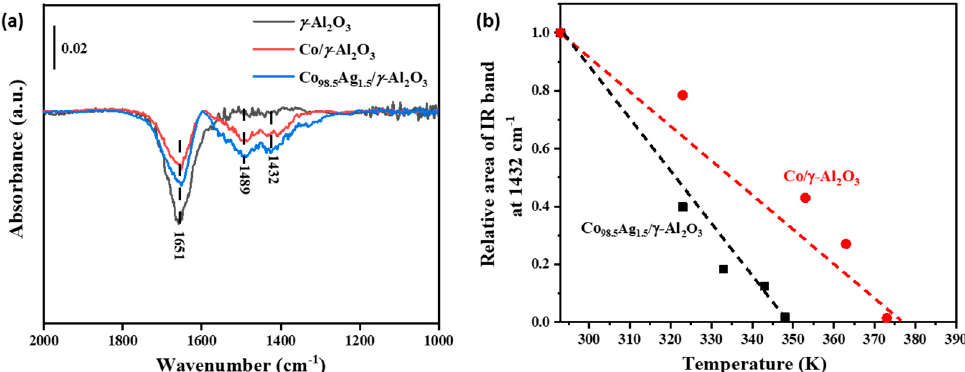
Figure 8. ( a ) Diffuse reflectance infrared Fourier transform spectra of NH 3 -adsorbed Co/ γ -Al 2 O 3 , Co 98.5 Ag 1.5 / γ -Al 2 O 3 , and γ -Al 2 O 3 samples at 343 K (using the spectra collected at ambient temperature as the background); ( b ) the relative intensity of the adsorbed NH 3 species on metallic Co sites (1432 cm − 1 ) as a function of the desorption temperature for Co/ γ -Al 2 O 3 and Co 98.5 Ag 1.5 / γ -Al 2 O 3 .